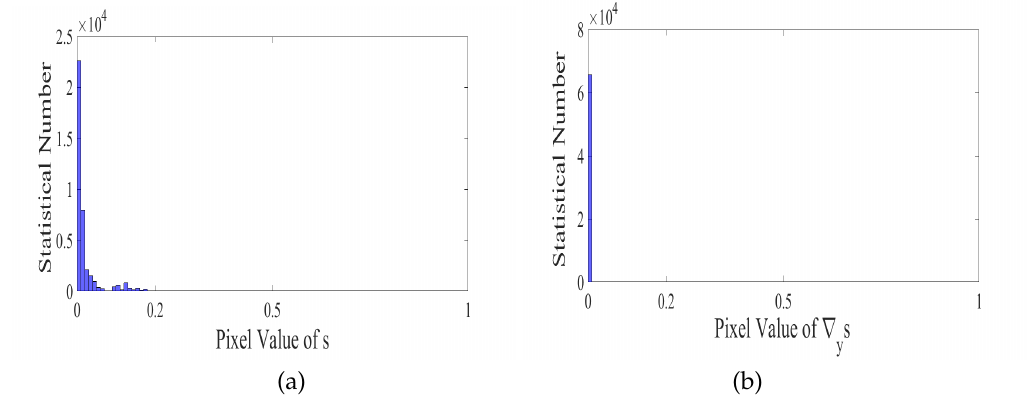
Figure 2. The number of nonzero elements of s ( a ) and ∇ y s ( b ), where s is estimated from a real image example (see Figure 3) by the method [26]. The y-axis represents the number of nonzero elements of s and ∇ y s , respectively, and the x-axis stands for the image pixel value whose range is [0,